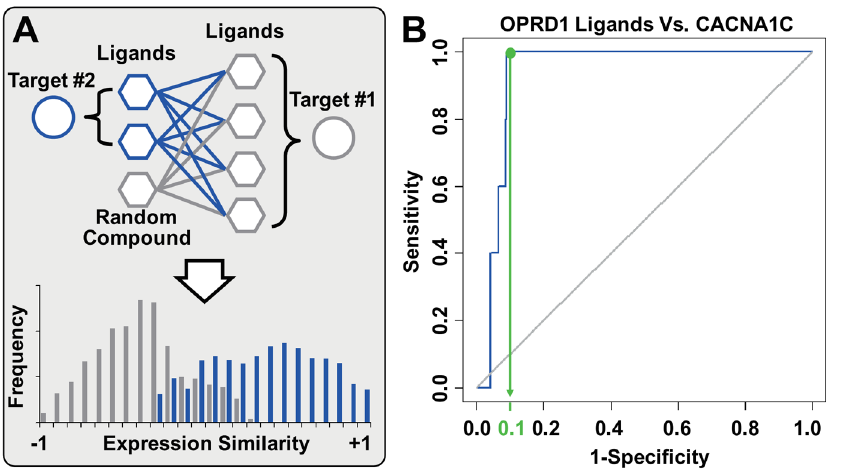
Figure 6. Identifying of target-target interactions by gene-expression similarity. (A) In some cases, the ligands of one target may generally show high LOI to another distant target. (B) The OPRD1 ligands (positive set) collectively show higher LOI to CACNA1C than other compounds (negative set). Setting the LOI corresponding to 90 percent specificity as threshold, we find that all OPRM1 ligands are above the threshold (p=1.08 6 10 2 5 ).